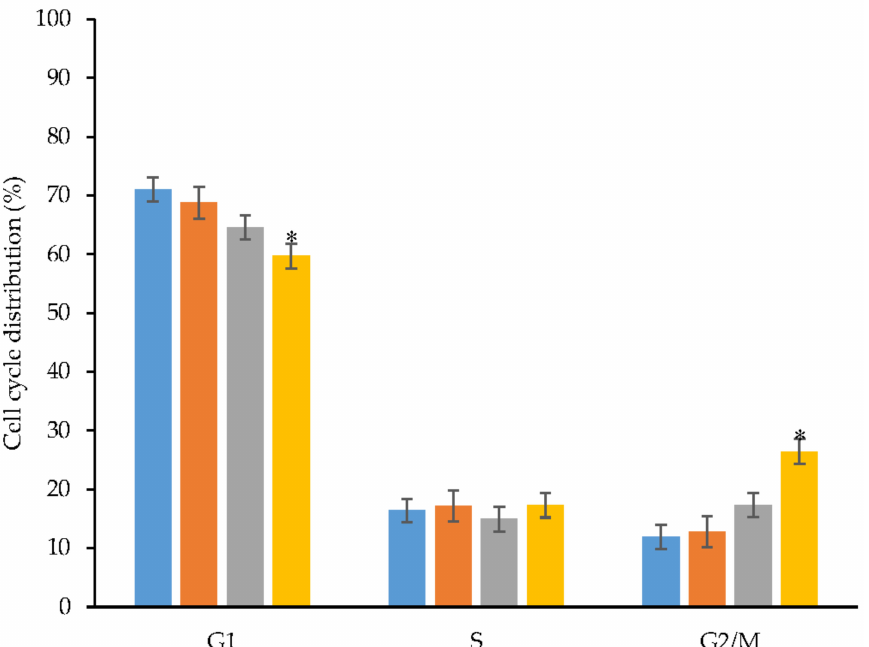
Figure 11. Cell cycle distribution of HT-29 human colon cancer cells exposed for 24 h to culture medium (control) ( (cid:4) ), blank NBSCh micelles ( (cid:4) ), free curcumin analog ( (cid:4) ) and CL-loaded NBSCh micelles ( (cid:4) ). * < 0.05 ( n =